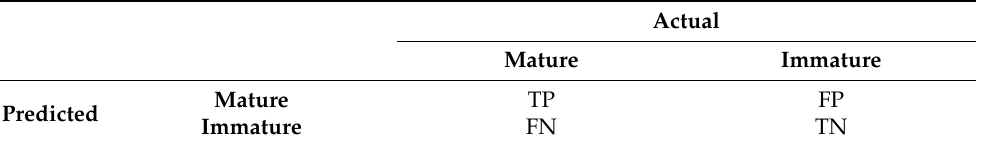
Table 2. Confusion table defining the true positive (TP), false positive (FP), false negative (FN), and true negative (TN). Actual Mature Immature Mature TP FP Predicted Immature FN